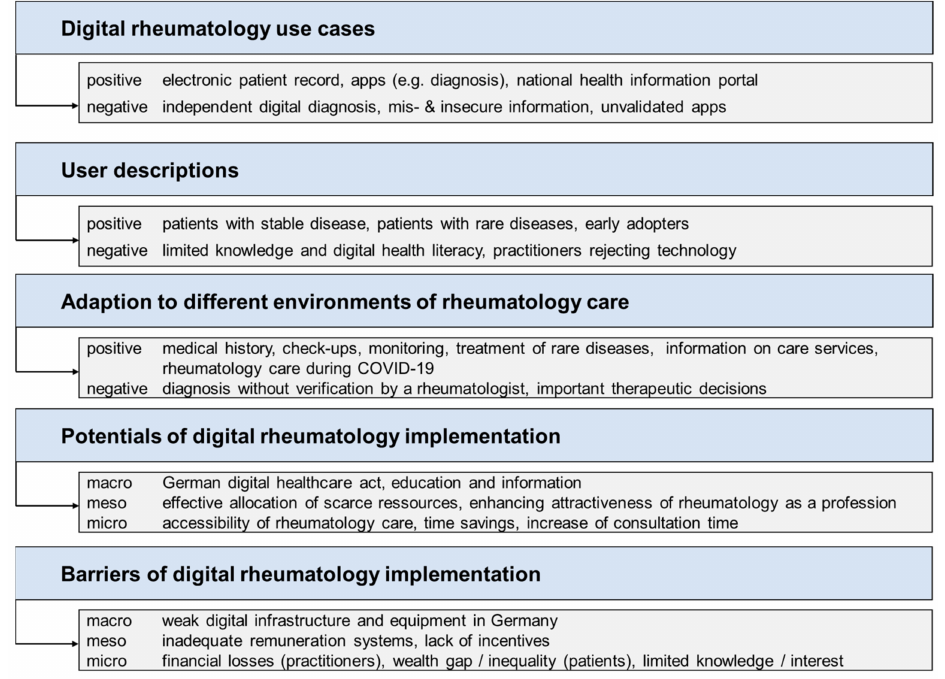
Figure 3. Qualitative content analysis: main categories (according to Kurkowski et al. 2020